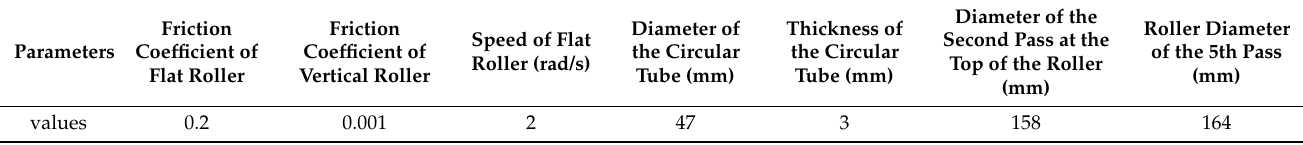
Figure 6. Finite element model of the roll forming.